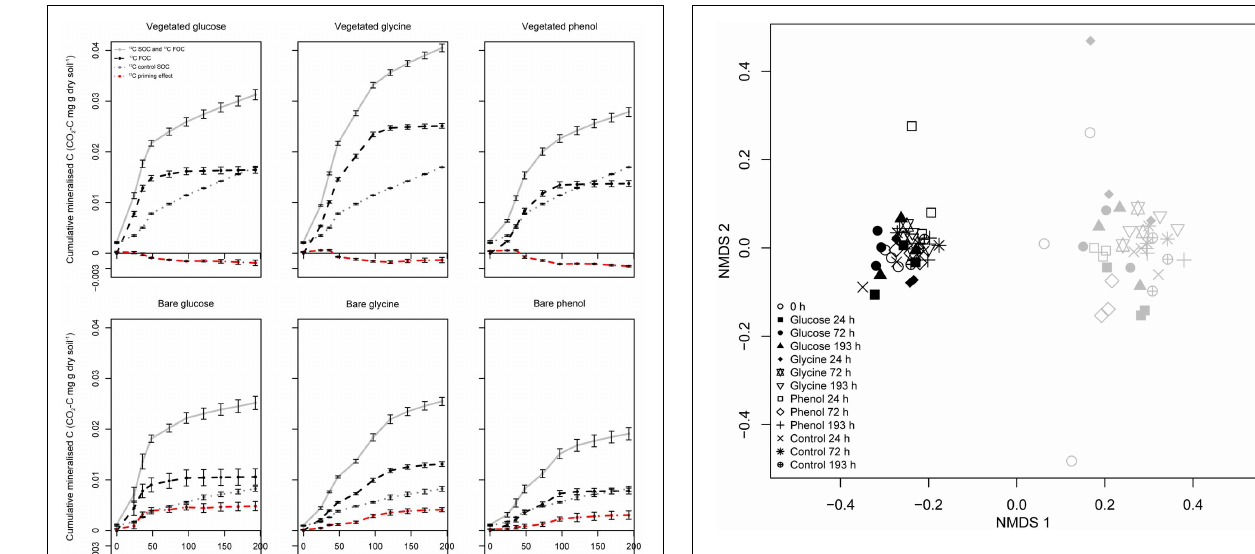
FIGURE 2 | Effects of substrate addition upon dominant soil bacterial populations in vegetated and bare soils. Two-dimensional NMDS ordination analysis of bacterial T-RFLP data from soils incubated with 13 C-labeled glucose, glycine, and phenol, and the water control treatments at 0, 24, 72, and 193h. Differences in the relative abundances of Alphaproteobacteria and Acidobacteria T-RFs were found to account for the majority of differences between vegetated and bare soil communities. Bacterial communities from vegetated and bare soils are denoted by black and gray symbols,